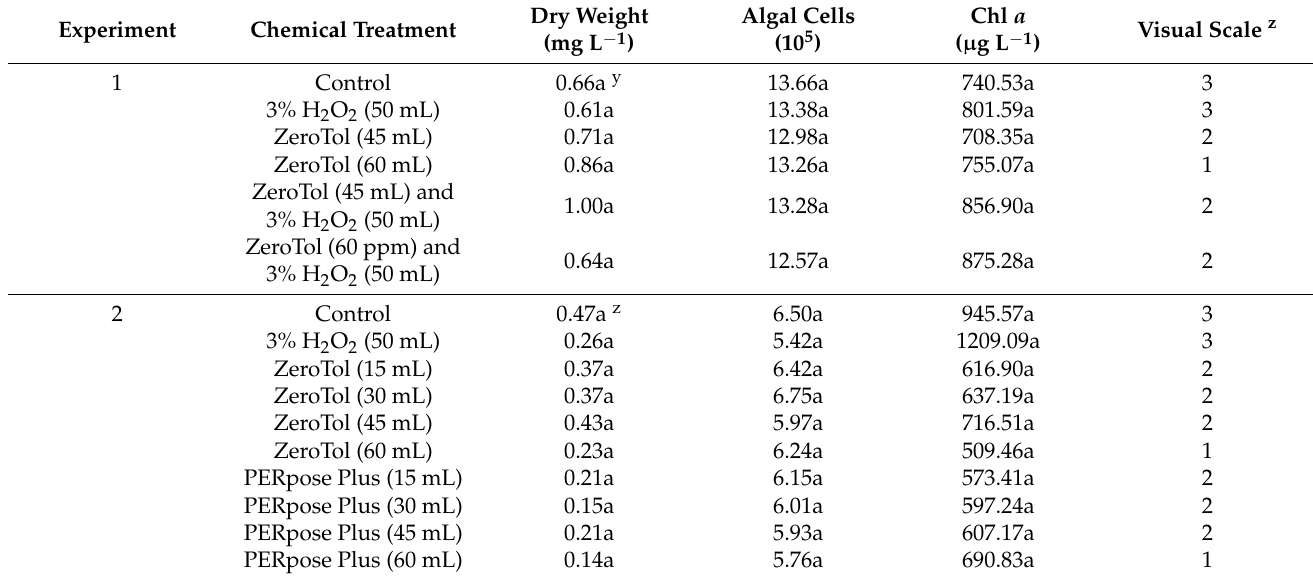
Table 8. The least square means of different rates applied weekly of three hydrogen peroxide products on algae samples taken 30 days after lettuce and basil were grown in the ebb and flow hydroponic systems in Stillwater, OK.